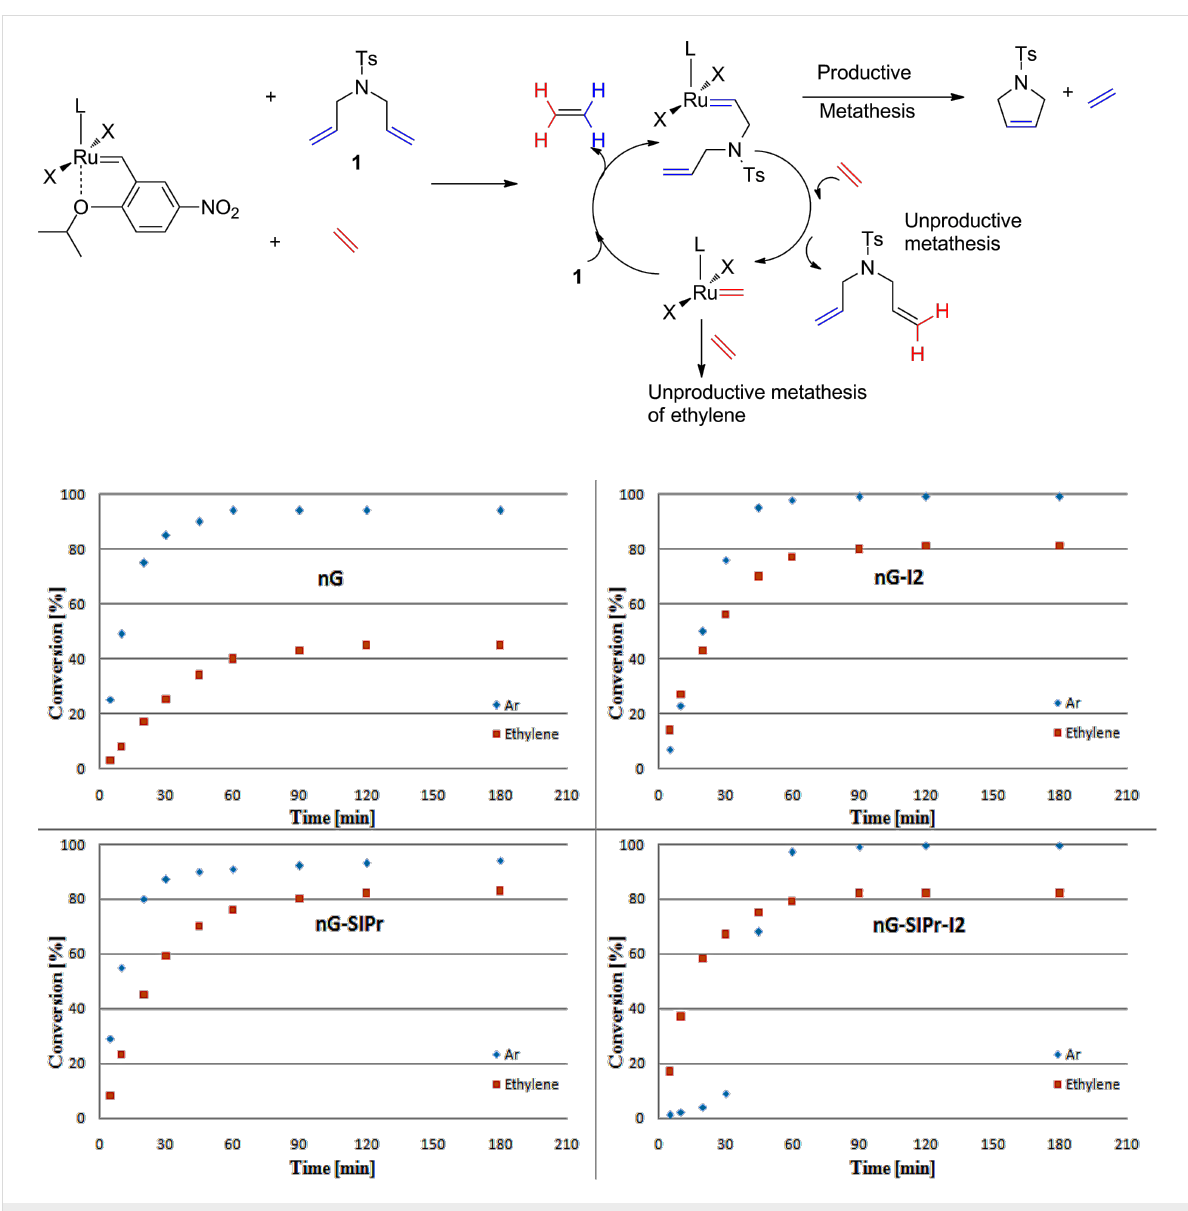
Figure 4: RCM of 1 (toluene, 0.05 M, 25 °C, [Ru] 0.01 mol %): top – productive RCM and possible non-productive events; bottom – reaction profiles of tested catalysts (blue diamonds – reaction under Ar, red squares – reaction under